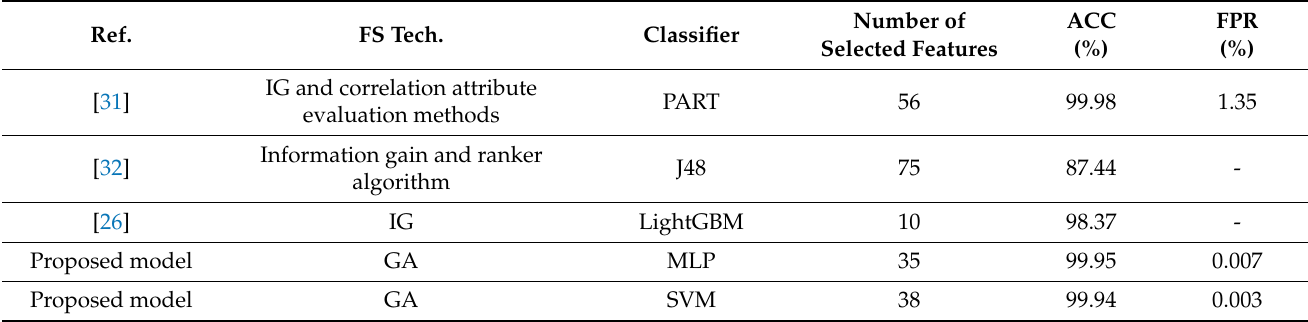
Table 13. Performance comparison with recent methods CIC-IDS-2017. Ref.